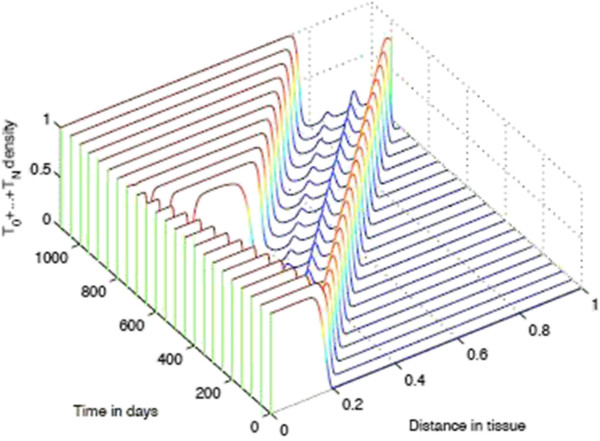
Changes in the spatial distribution of all tumour cells∑j=0NTjwithin the tissue for decreasingpiand costantki+. Plots showing detailed changes in the spatial distribution of all tumour cells ∑j=0NTj within the tissue over time in the case of immunoevasion. Parameter values pN=0.5 and ki+=constant.